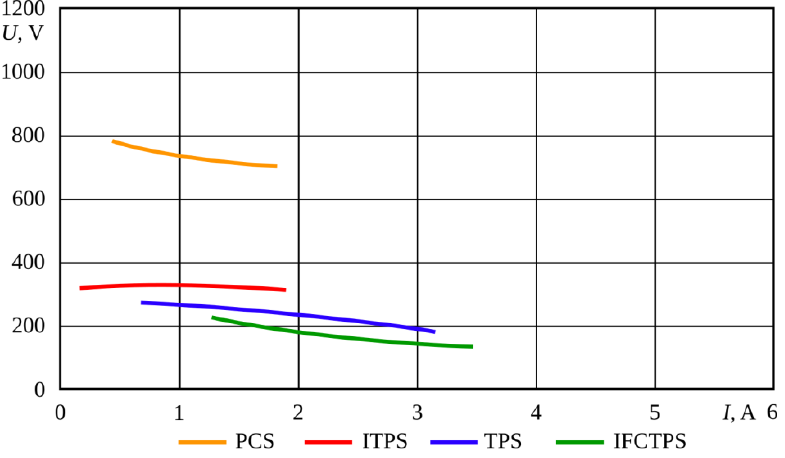
Figure 12. Control characteristics of the tested power supplies loaded with plasma reactor, plasma gas: argon, volumetric flow rate: 1.6 m 3 /h.